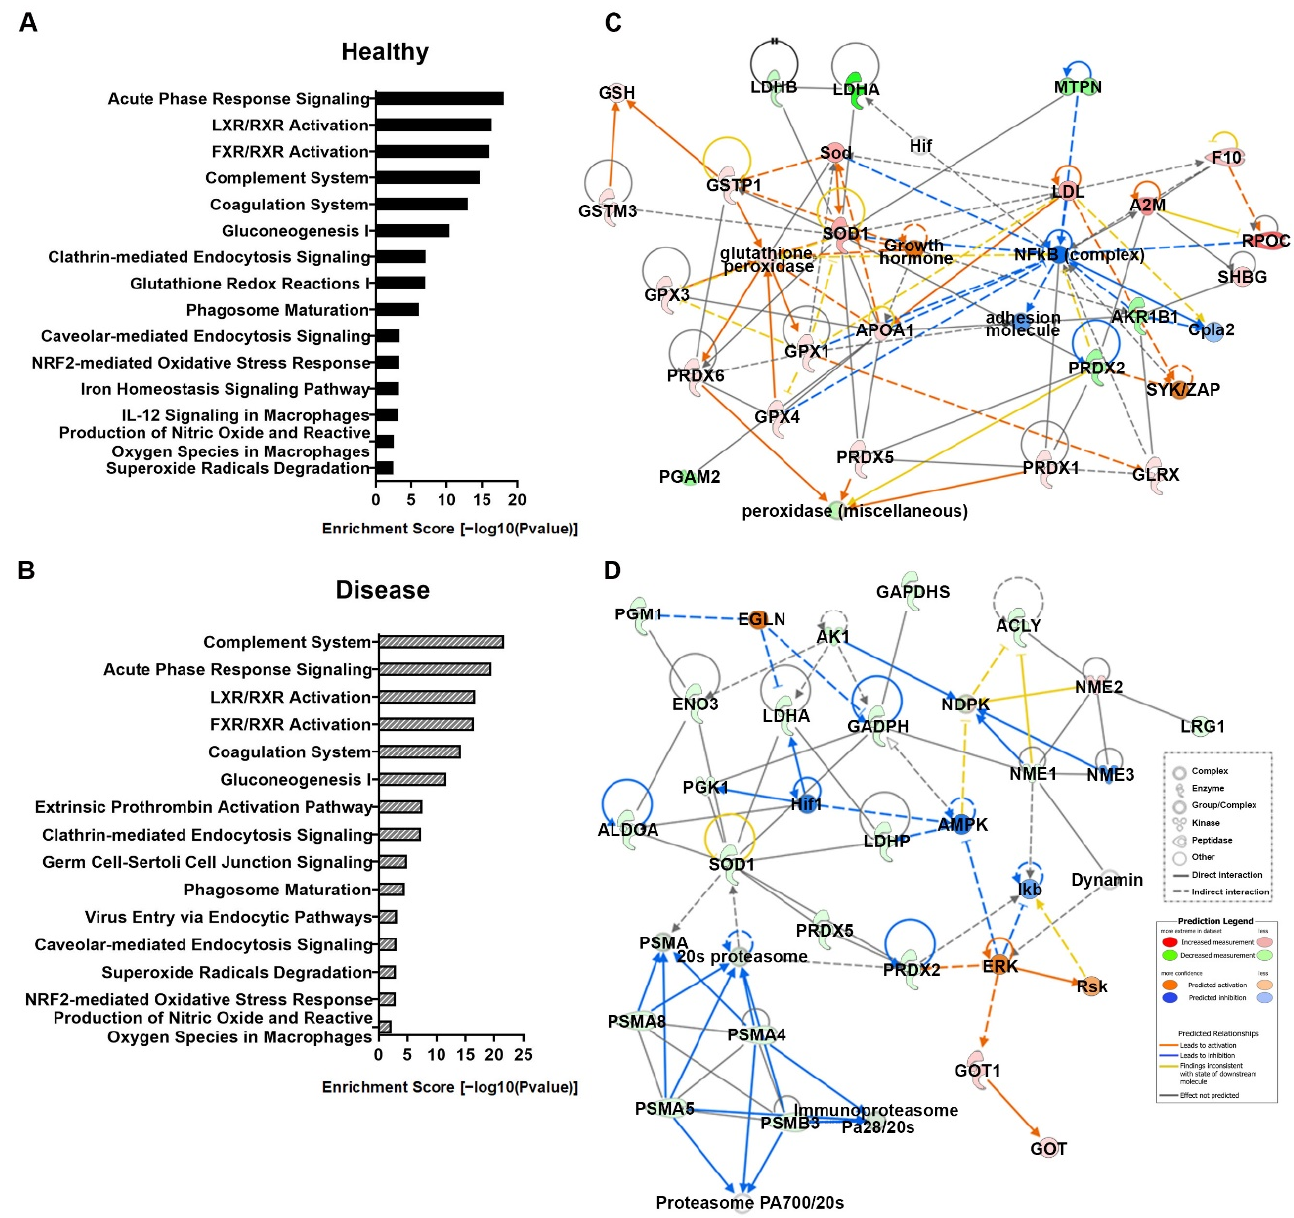
Figure 4. Top 15 enriched canonical pathways identified in IPA by DEPs in ( A ) healthy and ( B ) diseased conditions. The pathways are indicated on the y-axis. On the x-axis, the enrichment score ( − log10( p -value)) for each pathway is indicated by the bars. ( C ) Healthy top molecular network involving free radical scavenging, small molecule biochemistry and drug metabolism. ( D ) Disease top molecular network in conditions involving carbohydrate metabolism, nucleic acid metabolism, small molecule biochemistry. Upregulated proteins are represented in red and downregulated proteins are represented in green. Orange represents predicted activation, while blue represents predicted inhibition.